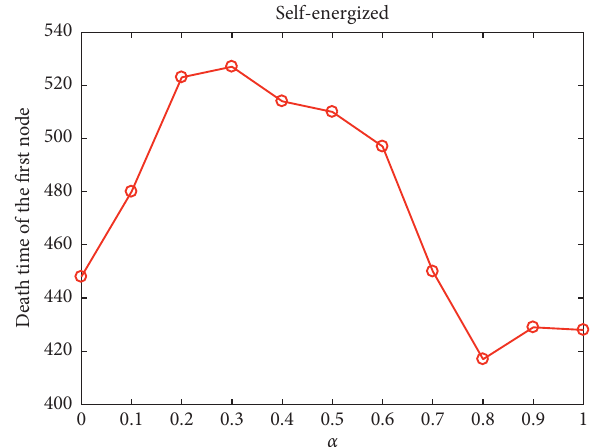
Figure 8: Impact of parameters α and β on the network lifetime.